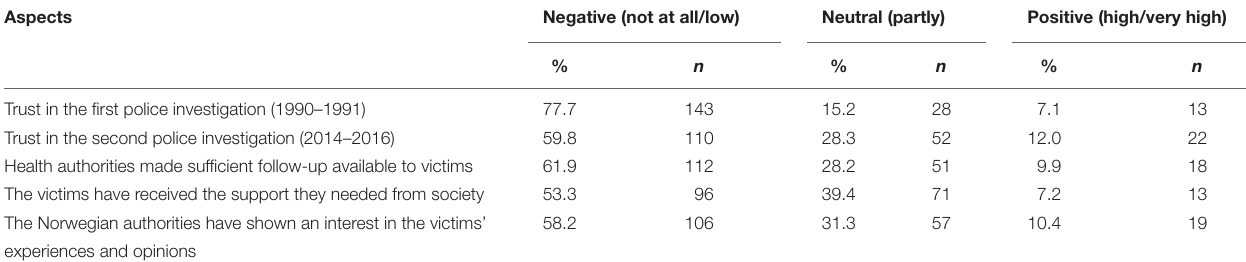
TABLE 2 | Participants’ perceptions of how the authorities handled the disaster